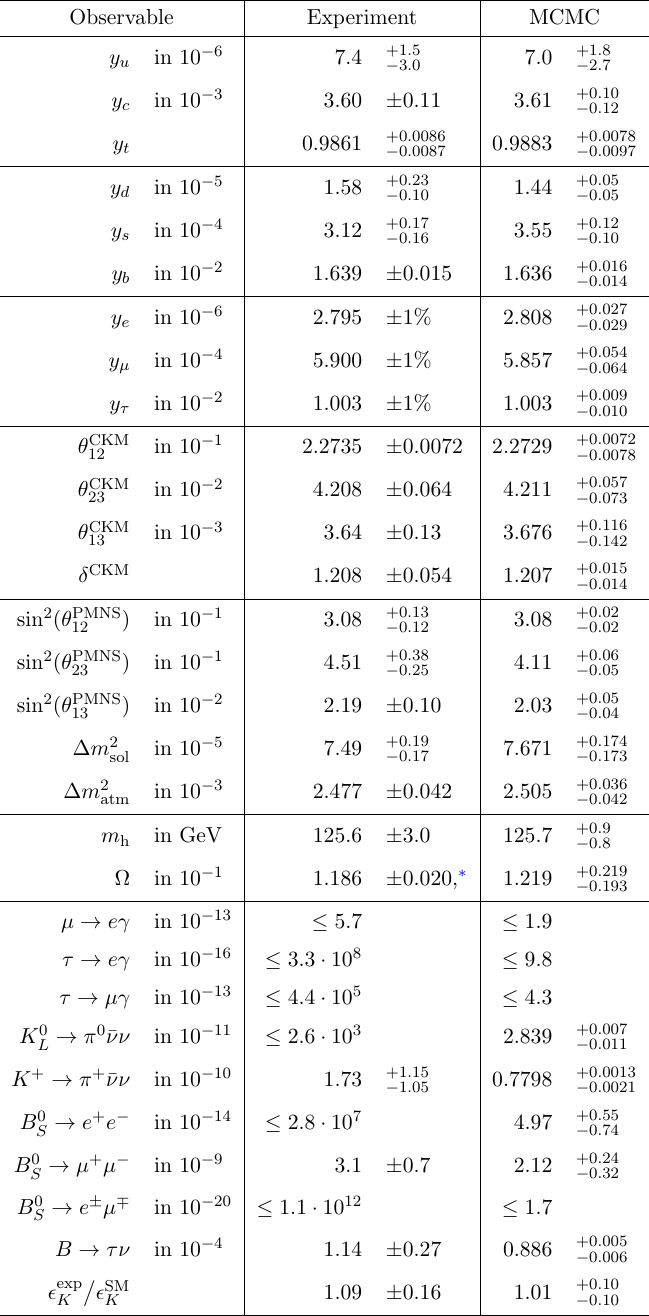
Table 2 . Experimental values of the observables and the 1 (cid:27) HPD intervals combined with the mode values of the observables of the MCMC analysis. The Yukawa couplings, the CKM and PMNS parameters, and the neutrino masses are given at M Z = 91 : 2 GeV. Note that although the Yukawa couplings of the charged leptons are measured far more precise than listed, we set an 1% uncertainty for the experimental values, what is roughly in accordance with the accuracy of the running used here. The same holds true for the Higgs mass, where the uncertainty of the theoretical calculation of about (cid:6) 3 GeV is much bigger than the experimental